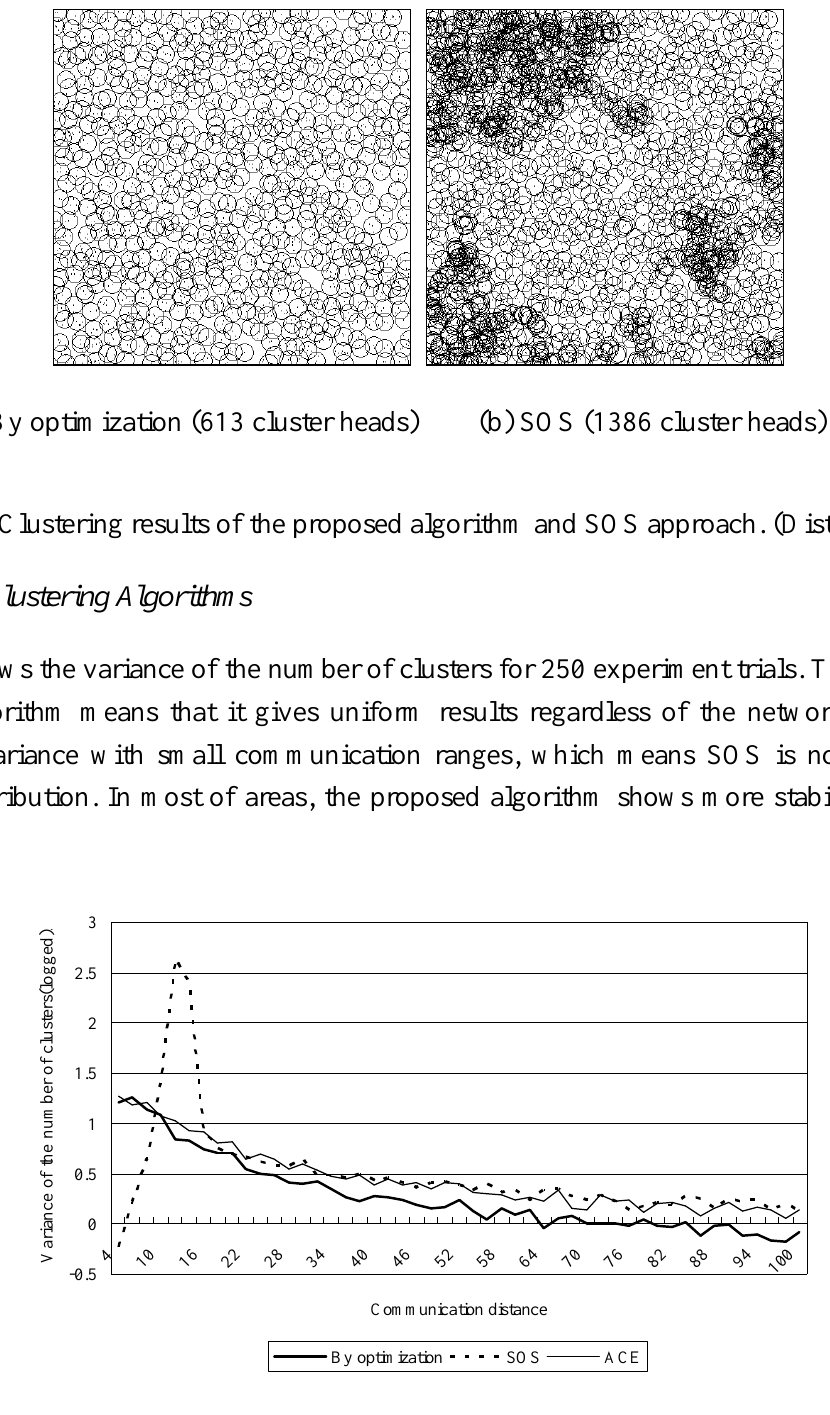
Figure 10. Variance of the number of